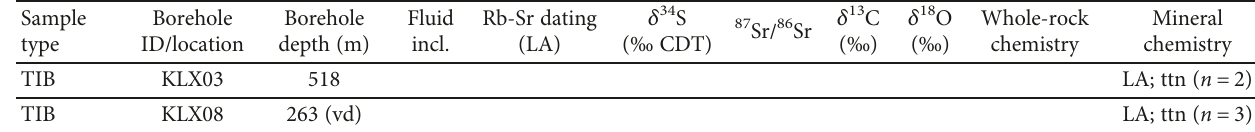
Table 2: Summary of rock samples and analytical techniques applied on